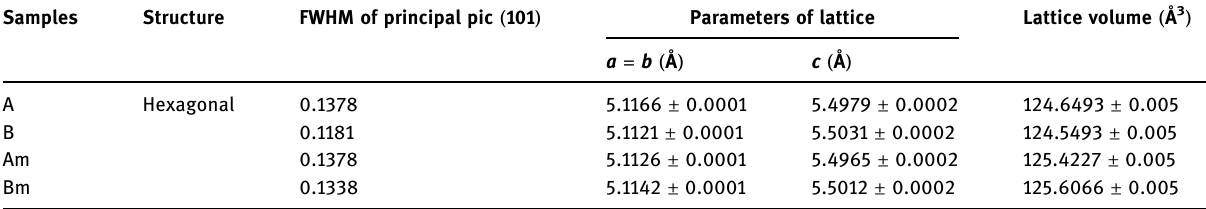
Table 2: FWHM, atomic parameters and the volume of the unit cell for the starting aggregates A and B, and Am and Bm mortars Samples